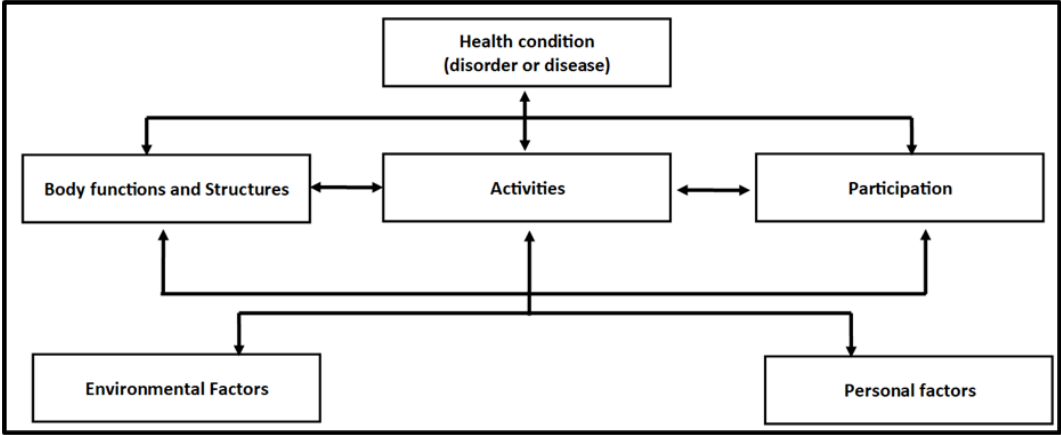
Figure 1. Interaction between ICF – WHO components [19].